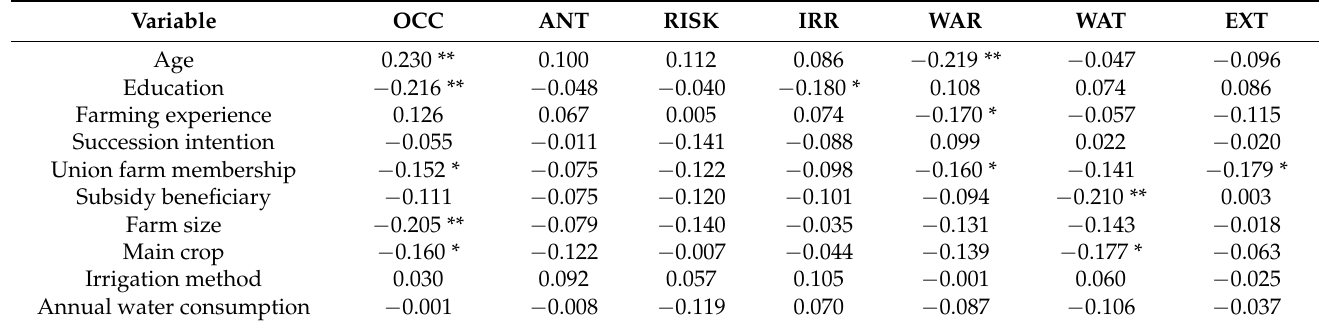
Table 4. Sociodemographic drivers of climate change awareness.